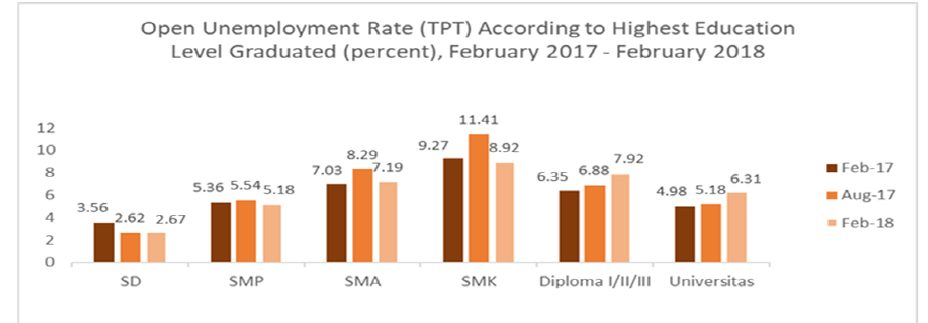
Figure 1: Unemployment Rate According to Educational